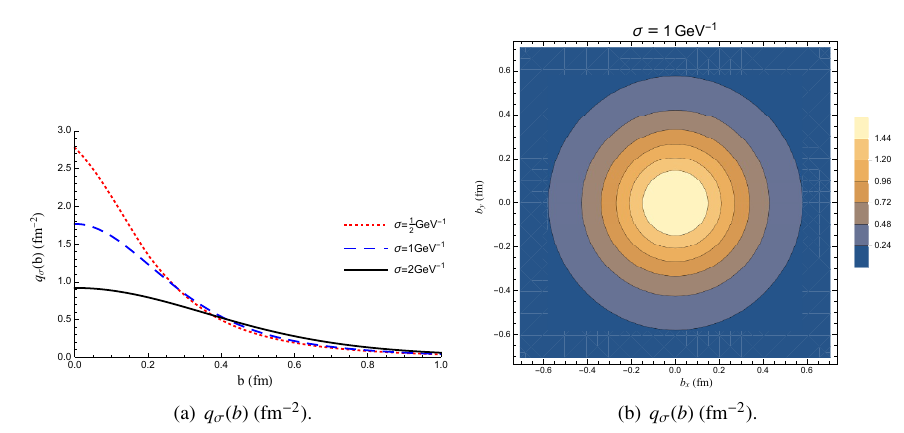
Figure 2. Contour plots of the IPD q ( b ) with a wave packet with σ = 1GeV − 1